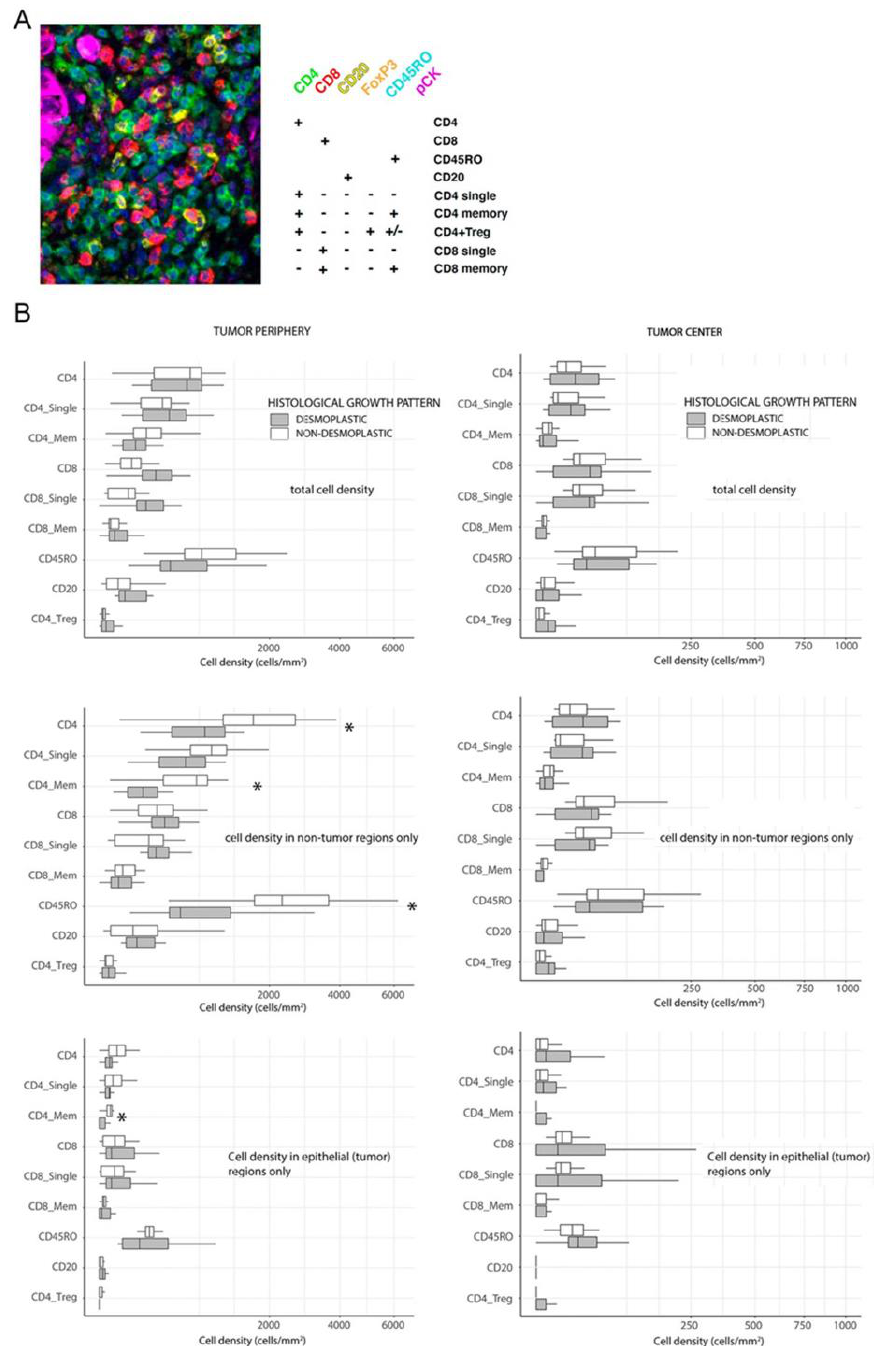
Figure 1. ( A ) Marker combination to identify each of the lymphocyte subsets assessed in the study. ( B ) Boxplots of cell densities (cells/mm 2 ) for each of the subsets assessed and stratified by HGP. We differentiated cell counts according to different topographic locations in the tumor, either in the tumor periphery or in central tumor areas as well as differentiating whether infiltrates were located in the stroma or in tumor glands. Tumor periphery was defined as the tissue fraction from 100 μ m of the proximal liver parenchyma until the first row of tumor cells, thus, including the capsule in dHGP CRC-LM and any rare portion of peritumoral stroma in ndHGP CRC-LM. Asterisks illustrate p value < 0.05, U-Mann Whitney test comparing dHGP vs. ndHGP.